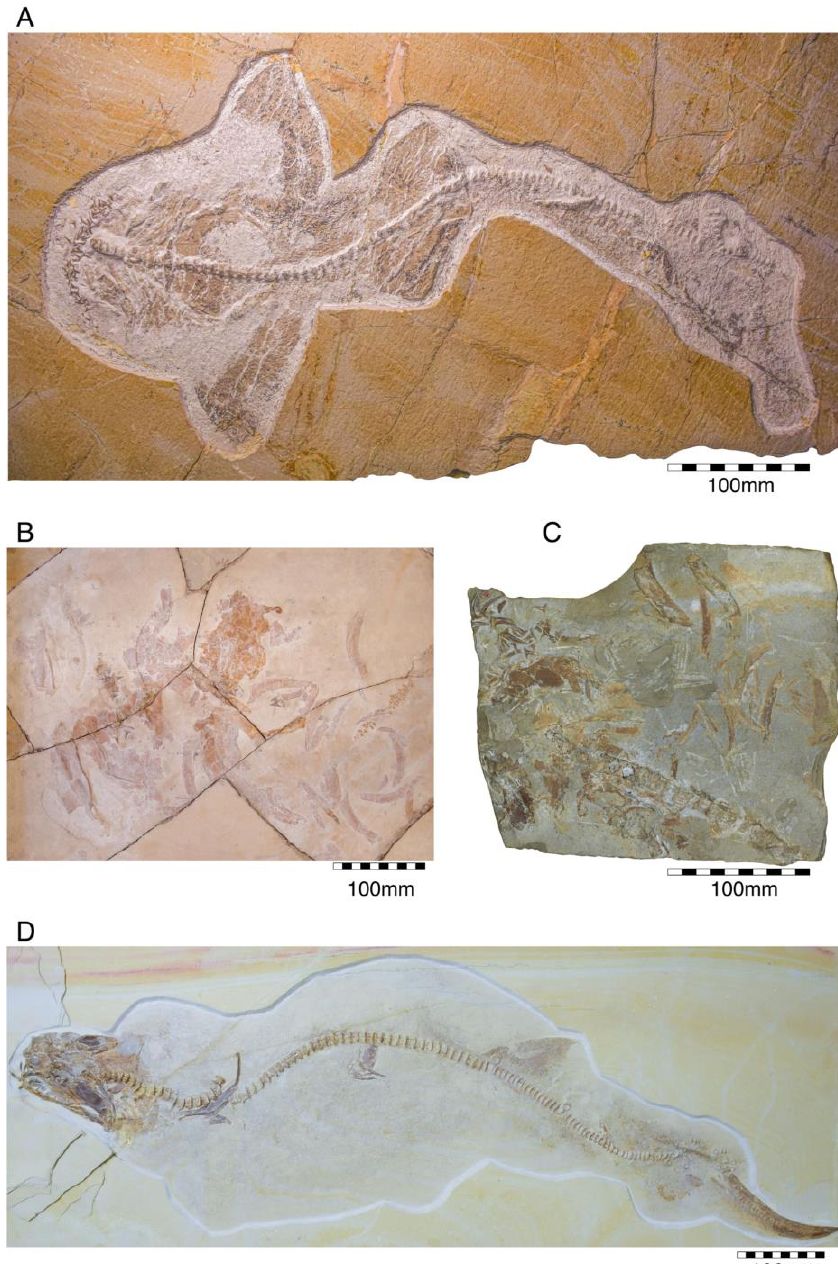
Figure 13. Specimens of † Sphenodus Agassiz, 1843 [171] found in the Solnhofen Archipelago. ( A ) Holotype specimen of † S. macer (Quenstedt, 1851 [106]) (SMNS 80142-44) from the upper Kim- meridgian of Nusplingen. ( B ) Fragmentary specimen of † S. macer (MCZ 13389) from the Upper Jurassic of Solnhofen. ( C ) Holotype specimen of † S. nitidus Wagner, 1862 [105] (BSGP-AS VII 647) from the Tithonian of Solnhofen. ( D ) † S. nitidus (SMNS 96844-7) from the Kimmeridgian of Nusplingen.